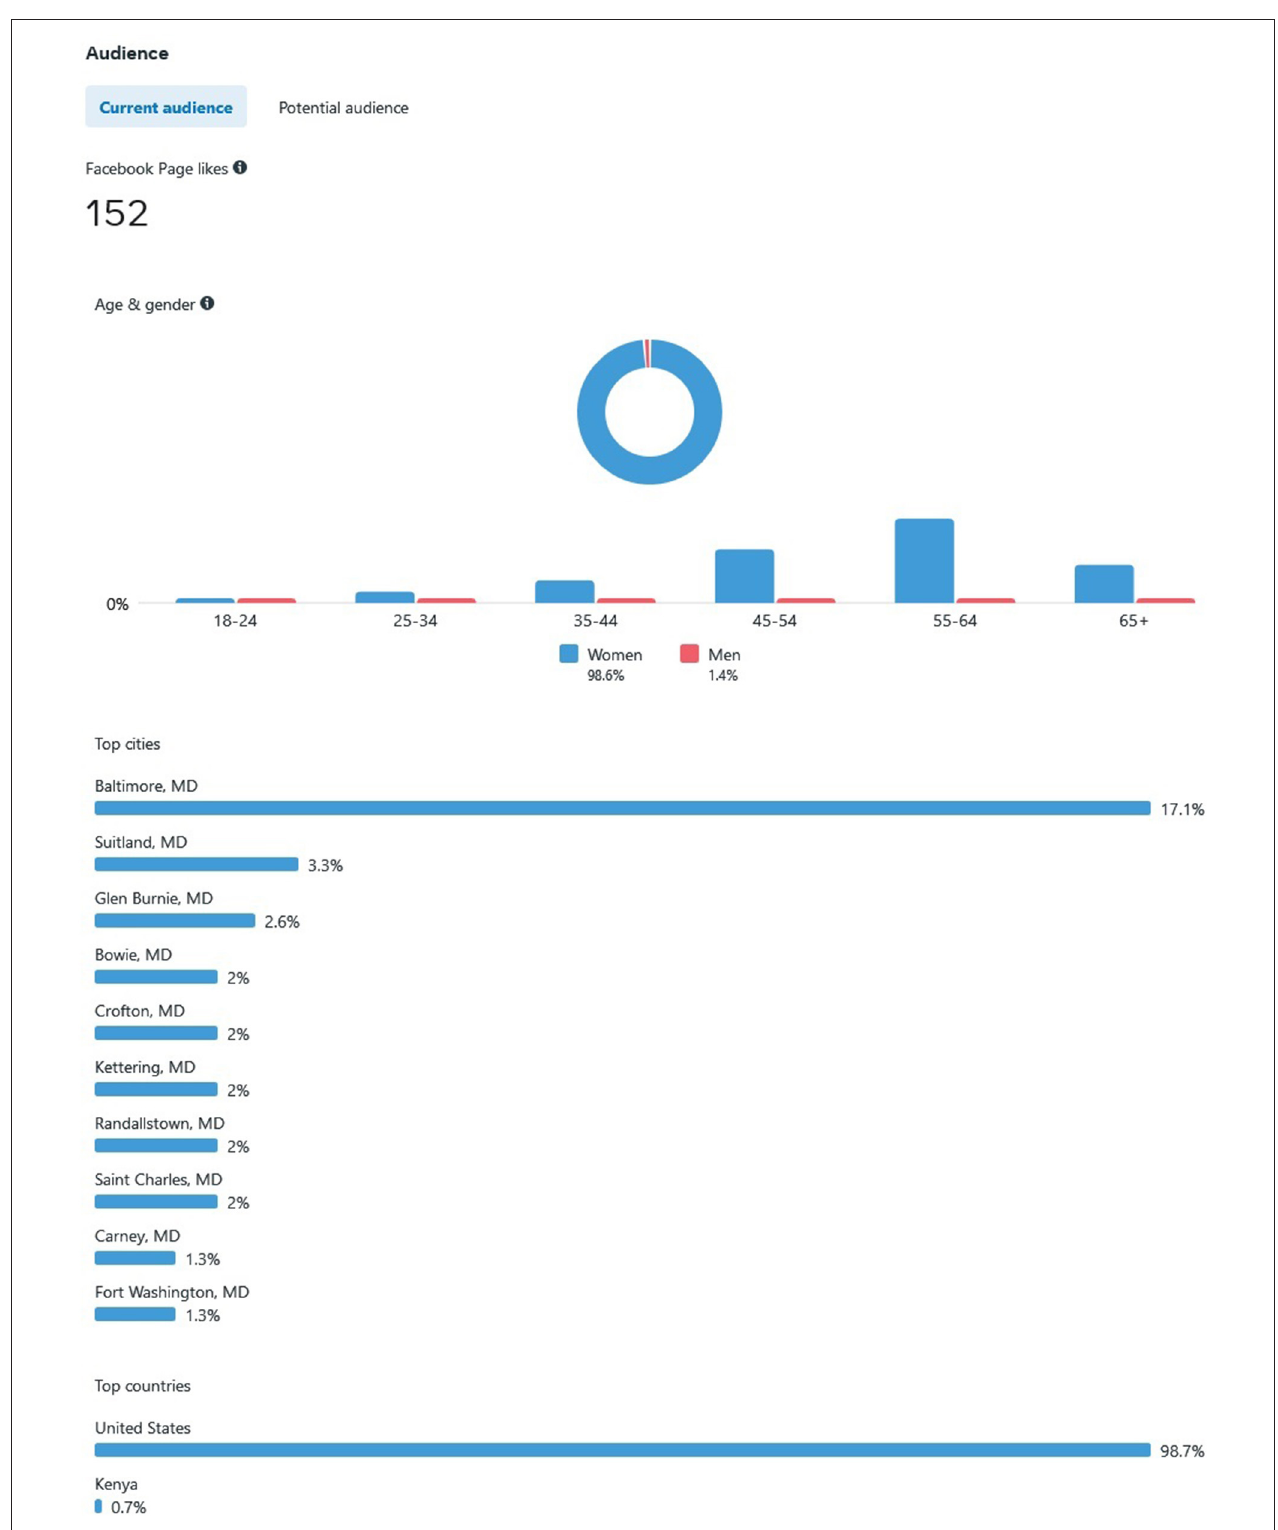
FIGURE 2 | Meta Ad Insights from Eligible Target Population from 5 January 2022 to 7 June 2022.